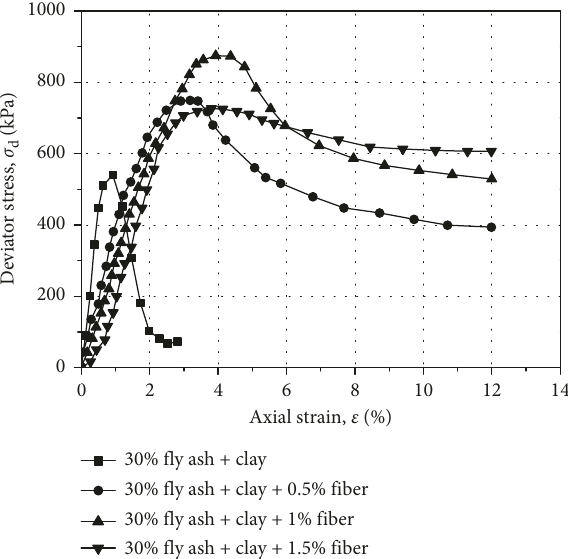
Figure 9: Relationship between UCS and curing period for dif- ferent proportions of fly ash. Table 5: Effect of fly ash inclusion and curing period on UCS specimens.